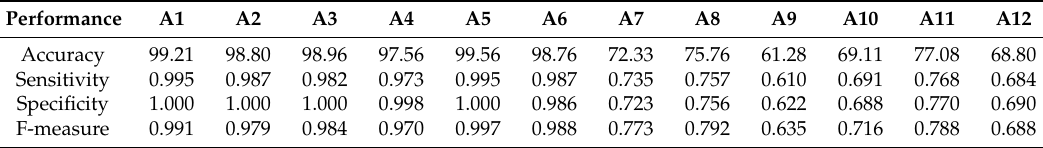
Table 4. Performance evaluation for the heterogeneous ensemble model (A1 = Standing, A2 =